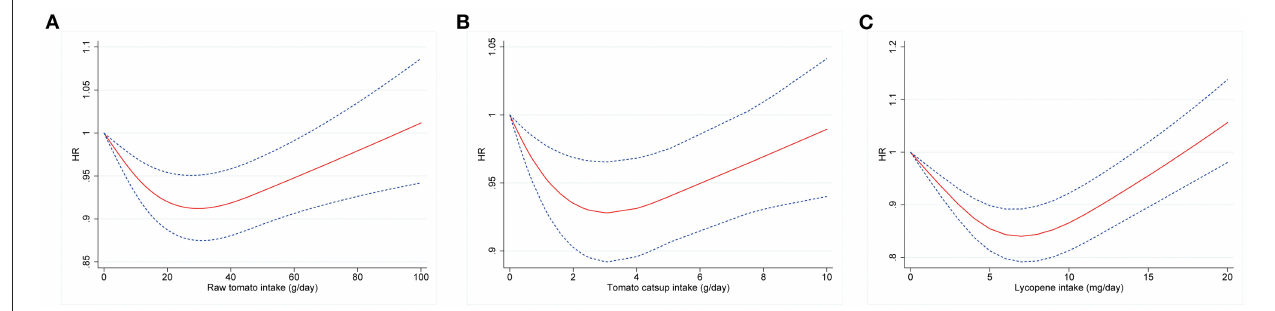
FIGURE 1 | Dose-response analyses for the association between intakes of raw tomato (A) , tomato catsup (B) , or lycopene (C) and all-cause mortality were performed using restricted cubic spline model with 3 knots at 10th, 50th and 90th percentiles. Models were adjusted for age, sex, race, body mass index, education, smoking status, total energy intake, alcohol drinking status, marital status, randomization arm, aspirin use, history of hypertension, history of diabetes, history of stroke, history of heart attack, vegetables intake, and fruit intake. Red solid lines represent point estimates and blue dashed lines represent 95% confidence intervals (CIs).